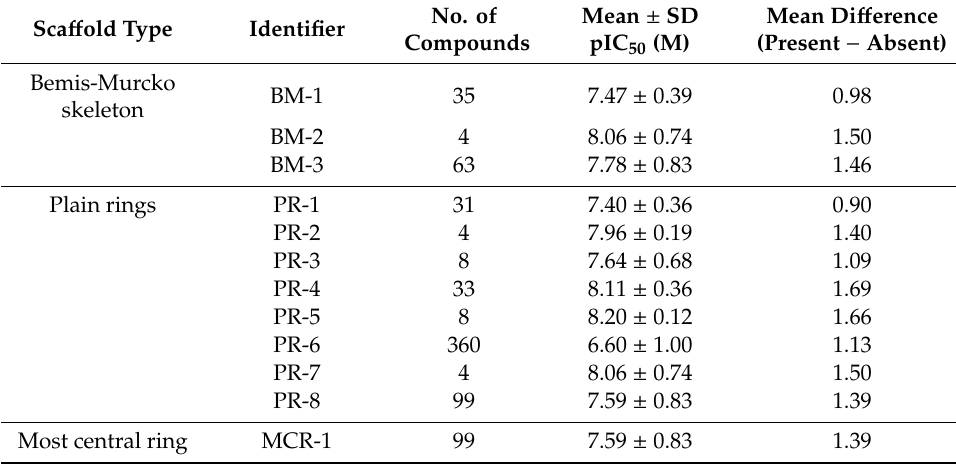
Table 1. Structural sca ff olds associated with significantly higher biological